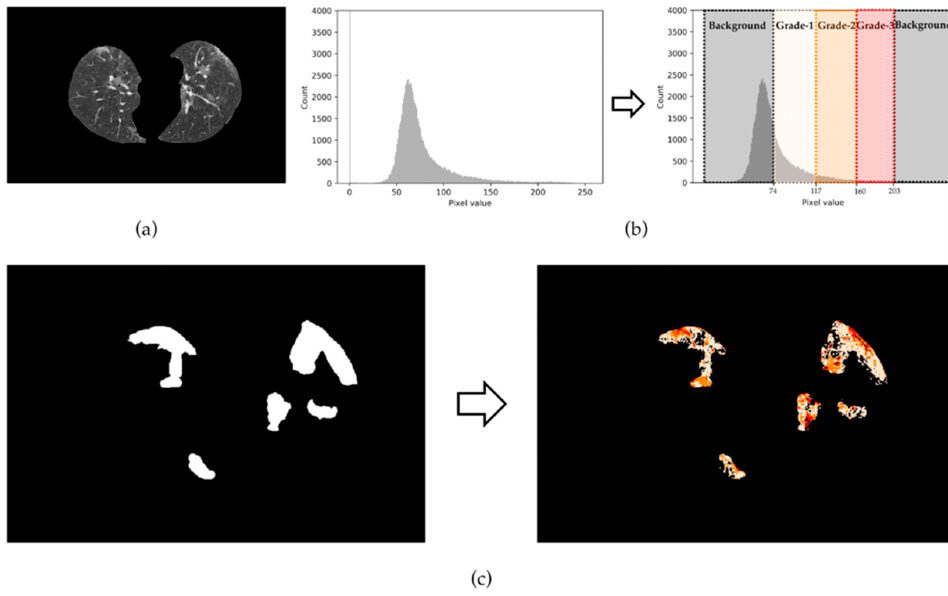
Figure 3. Visualization of label refinement (g = 3): ( a ) is the lung image segmented from a CT image. The left part of ( b ) is the histogram of ( a ) and we grade the pixels based on the pixel distribution of the infected and uninfected areas in the lung; ( c ) shows the lesion labels before and after the refine- ment.